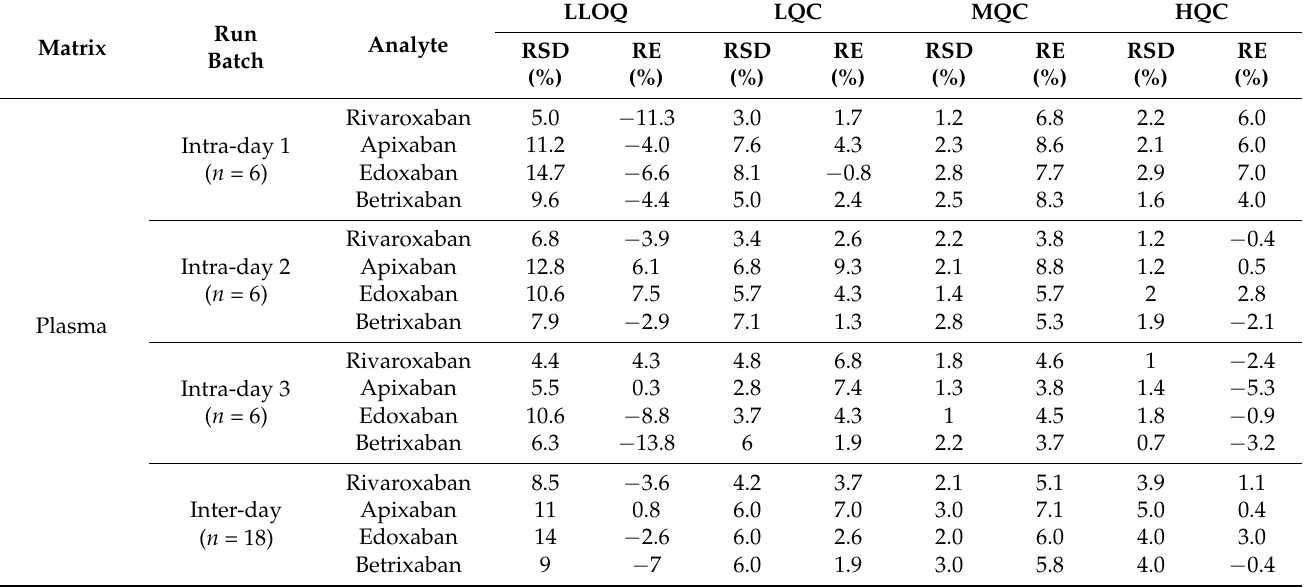
Table 3. Intra-day and inter-day accuracies and precisions of all